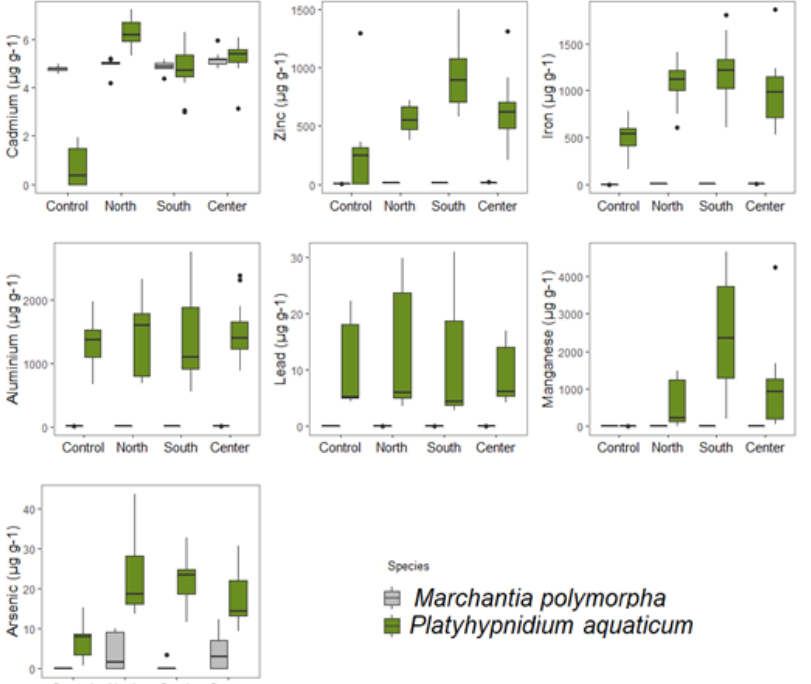
Figure 4. Concentrations ( µ g g − 1 ) of metals (Cd, Zn, Fe, Al, Pb, Mn and As) in Marchantia polymorpha and Platyhypnidium aquaticum , for water quality in different study areas. Boxplots showing the out- liers (black circles) Table 3. Mann – Whitney U test for heavy metal concentrations in Platyhypnidium aquaticum and Marchantia polymorpha .